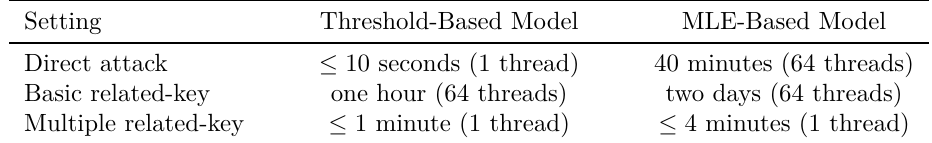
Table 9: Comparison of the running times of the threshold-based and MLE-based models.